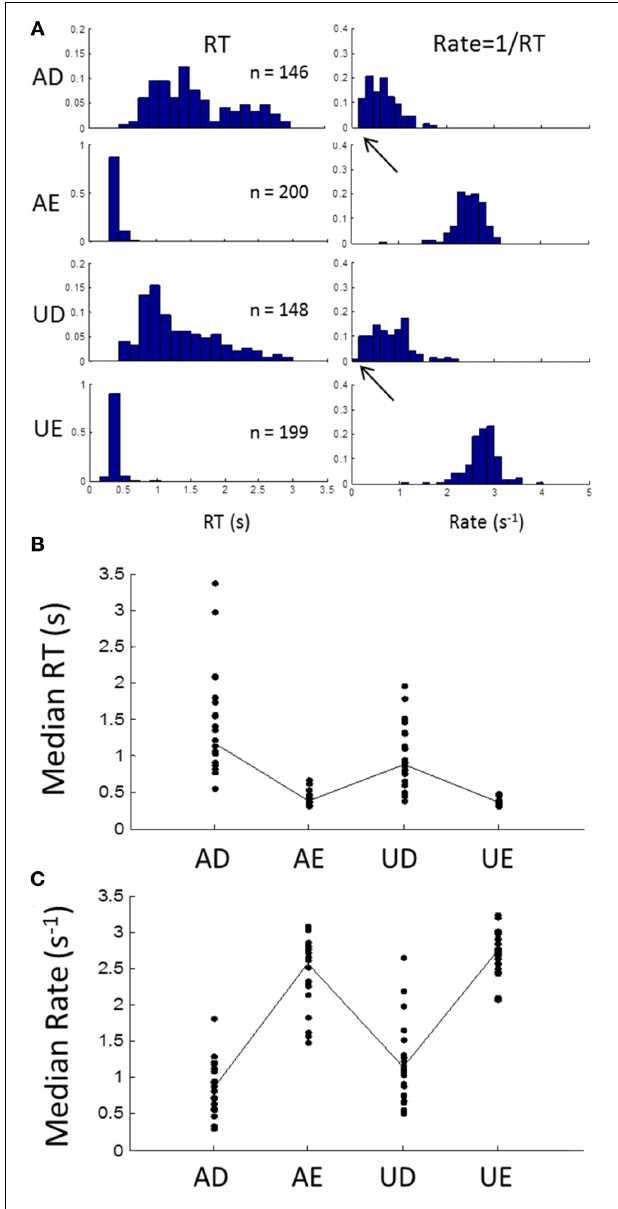
FIGURE 2 | (A) An example of an individual subject’s frequency distributions of RT (left column) and rate (right column) for the 4 different blocks (AD, accurate and difficult; AE, accurate and easy; UD, urgent and difficult; UE, urgent and easy; see Methods). In the easy tasks, RTs are brief with few errors (block size was 200 trials). For the difficult tasks RTs are much more variable with about 25% error rate. In the rate-domain, dispersion is similar for all blocks with a shift to lower rates for the difficult tasks. Note that the shift approaches zero (arrows) suggesting possible truncation. (B) Median RTs for all subjects showing longer RTs for difficult blocks and more inter-subject variability. (C) Same as (B) but for median rates showing similar inter-subject variability for all